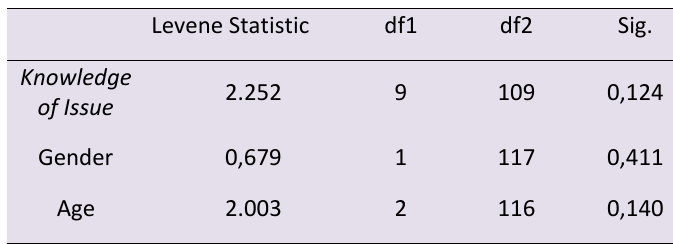
Table 3. Homogeneity Test Results